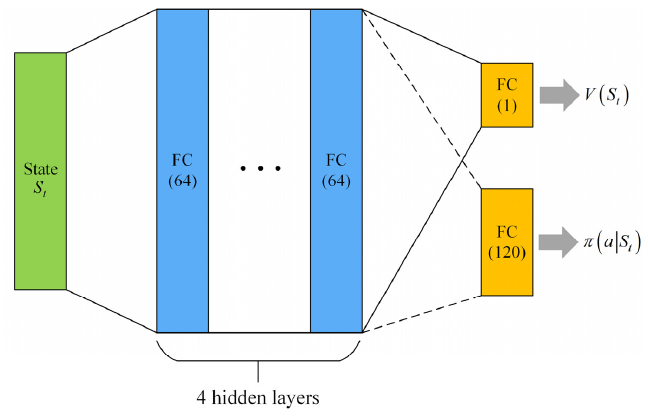
Figure 7. Neural network architecture for agent training.